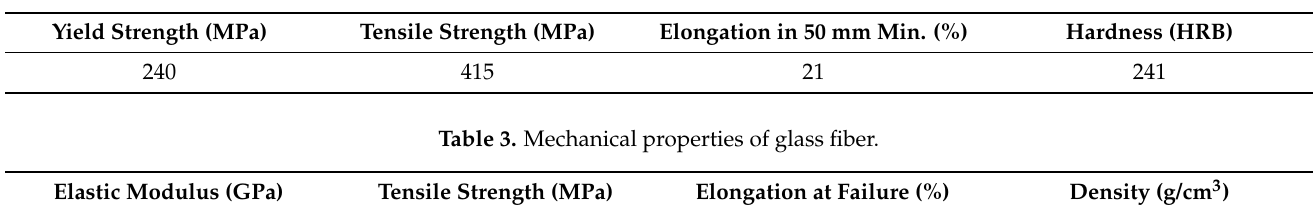
Table 2. Mechanical properties of ASTM A53 carbon steel alloy.